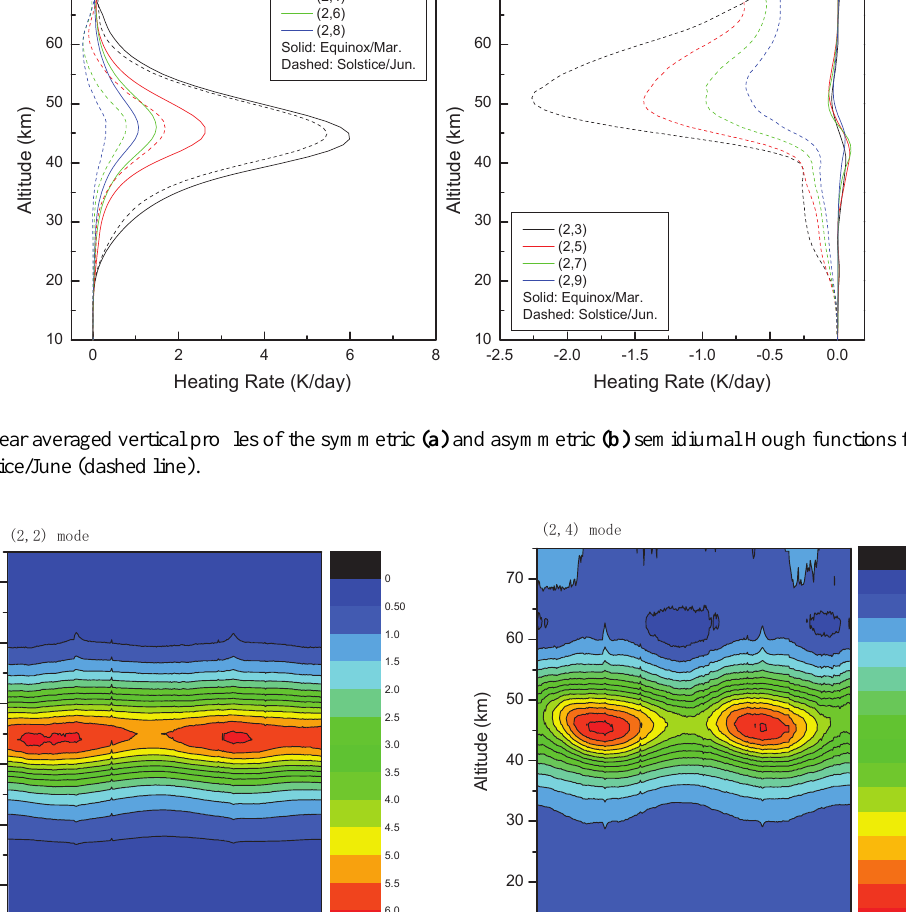
Solid: Equinox/Mar. Dashed: Solstice/Jun.